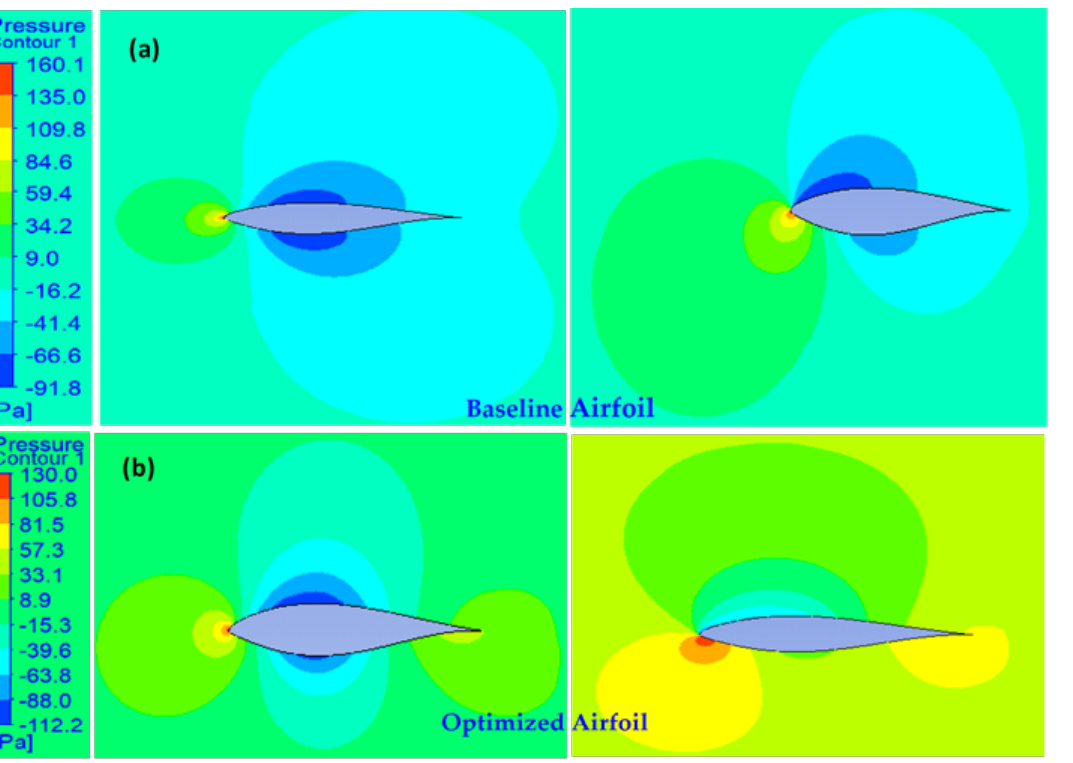
Figure 15. Pressure contour at 0° (left) and 6.2° (right) for the ( a ) baseline S809 airfoil and ( b ) optimized S809 airfoil. The velocity contours shown in Figure 16 are consistent with the results at angles of attack of 0 ◦ and 6.2 ◦ . The baseline and optimized airfoils with velocity contours are shown in Figure 16a,b, respectively. The left side of the figure shows the velocity contour at an angle of attack of 0 ◦ , while the right side shows the velocity contour at 6.2 ◦ . The